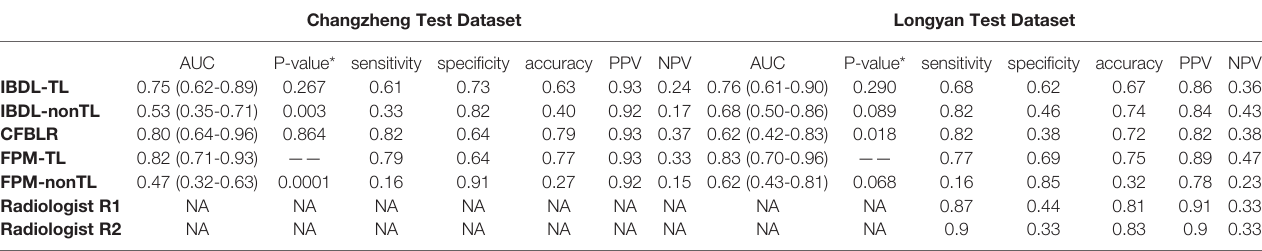
TABLE 3 | Summary of diagnostic indicators for each model and two clinicians (Our hospital, external hospital: AUC, sensitivity, speci fi city, accuracy, PPV and NPV). Changzheng Test Dataset